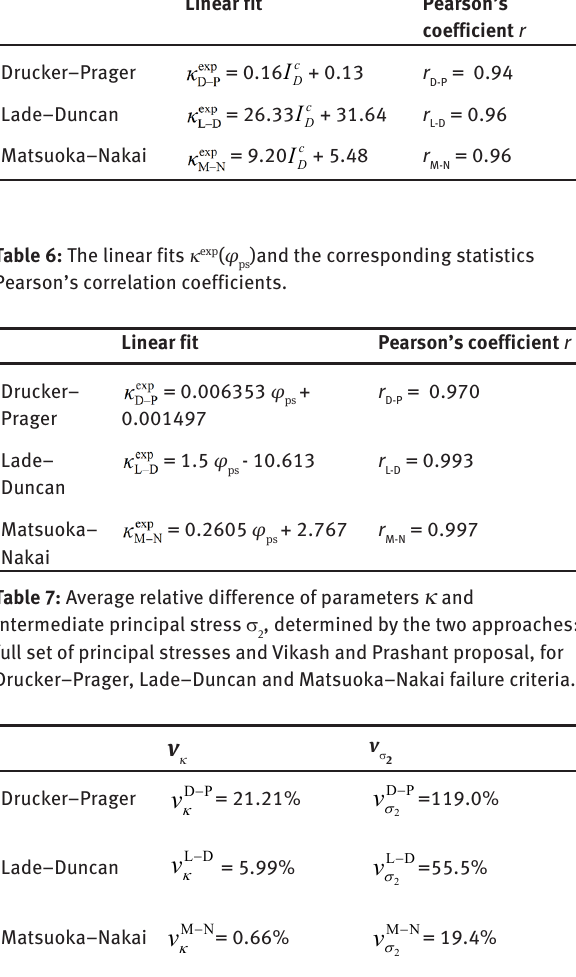
( ) c I exp κ ) and the corresponding Pearson’s D